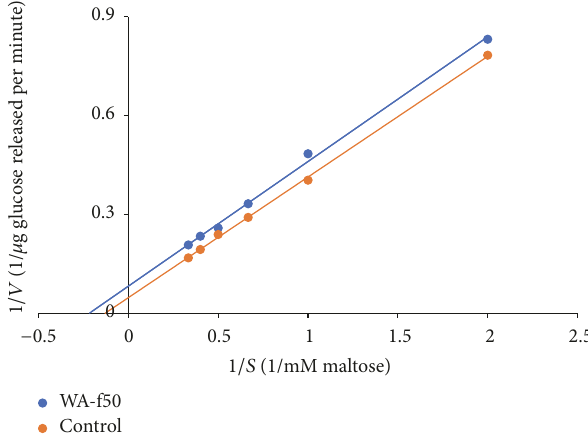
Figure 2: Lineweaver–Burk plot of rat intestinal 𝛼 -glucosidase inhibition by water extractable arabinoxylan (WA